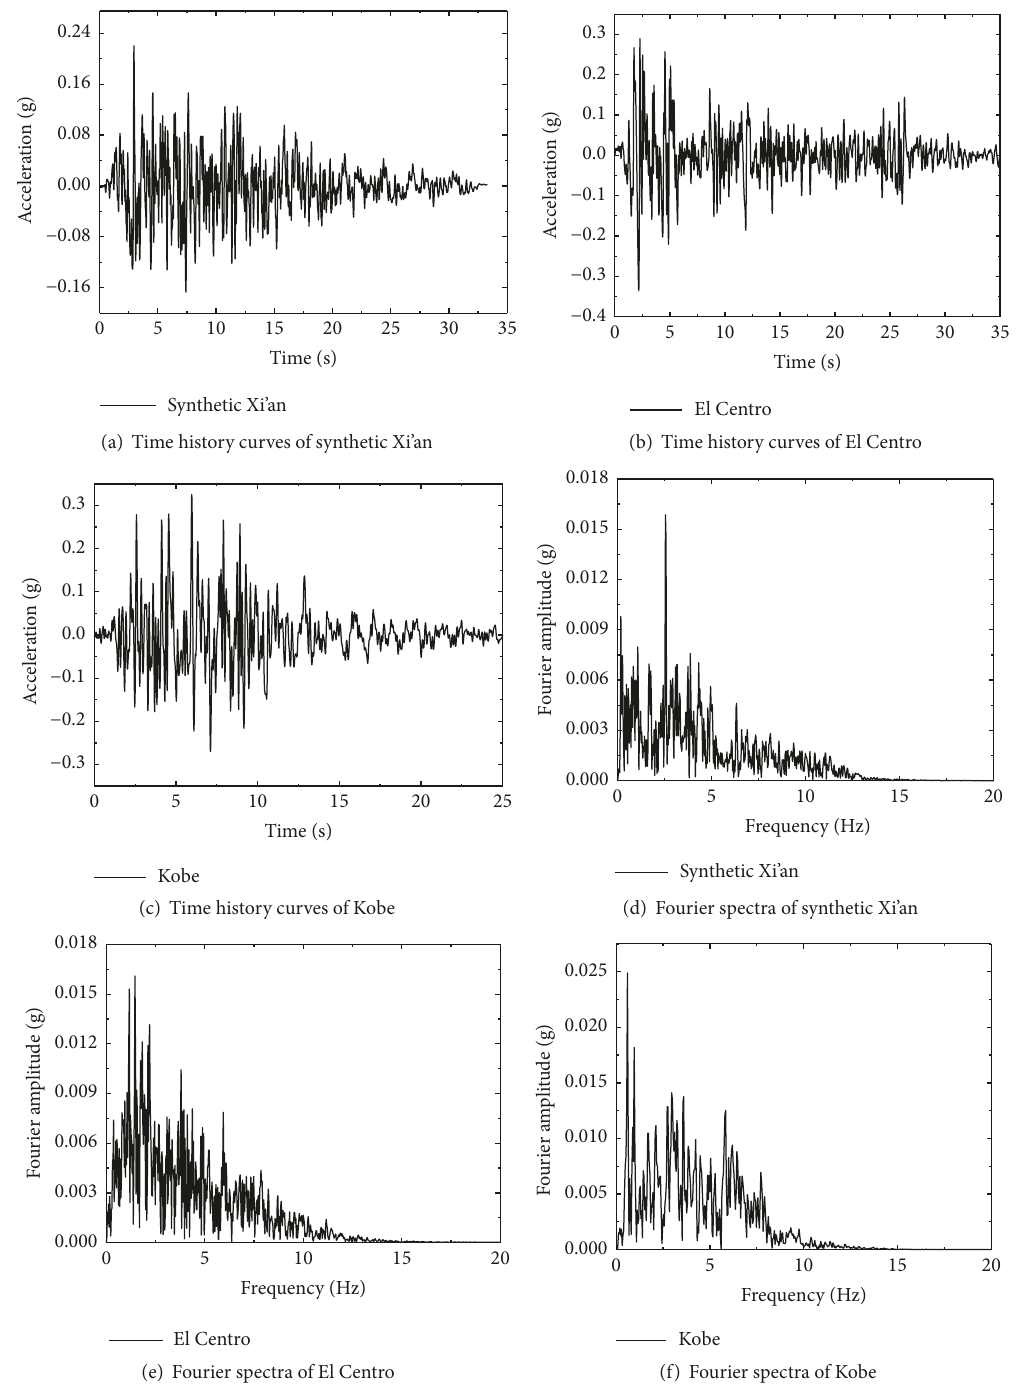
Figure 6: Time-histories and Fourier spectra of input earthquake waves.